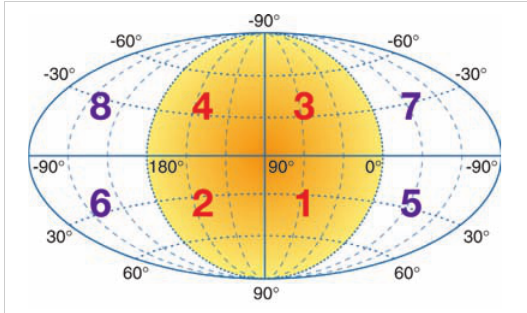
The coordinate system of the heart vectors enables the imaginary globe around the heart to be divided into hemi- spheres and octants. The apical hemisphere (orange) is lo- cated between 0° and 180° longitude (angle alpha), the basal hemisphere correspondingly between 0° and –180°. The y-axis points to the apex of the heart and therefore to a = 90° longitude and b = 0° latitude. The anterior (ventral) hemisphere extends from a = 90° over 180° to –90°, and the posterior (dorsal) hemisphere correspondingly from a = 90° over 0° to –90°. The latitude (angle beta) defines a superior ( b = 0° – –90°) and an inferior ( b = 0° – +90°) hemisphere. The octants are defined as follows: octant 1: apical inferior pos- terior; octant 2: apical inferior anterior; octant 3: apical supe- rior posterior; octant 4: apical superior anterior; octant 5: basal inferior posterior; octant 6: basal inferior anterior; octant 7: basal superior posterior; octant 8: basal superior anterior. Numbers of apical octants are given in red; numbers of basal octants are given in